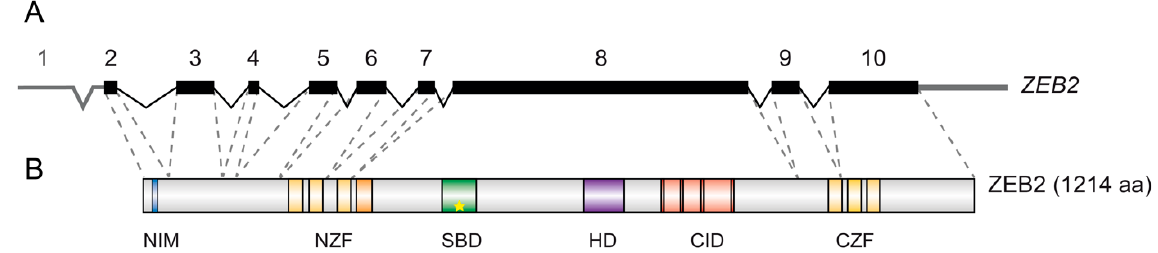
Figure 2. ZEB2 Gene and protein architecture: ( A ) human ZEB2 gene exon/intron is represented. Exon 8 encodes for about 60% of the protein. ( B ) ZEB2 protein structure. NIM: NuRD-Interacting Motif, NZF; CZF: N- and C-terminal Zinc Finger clusters; SBD: Smad-Binding Domain. The star in the SBD represents the essential residues in the SBD [91]; HD: Homeodomain-like Domain, CID: CtBP-Interacting Domain.